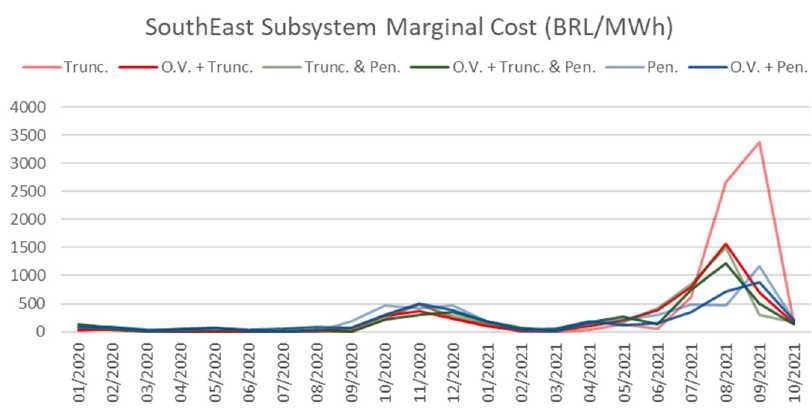
Figure 16. Marginal cost (BRL/MWh) related to the southeast subsystem.